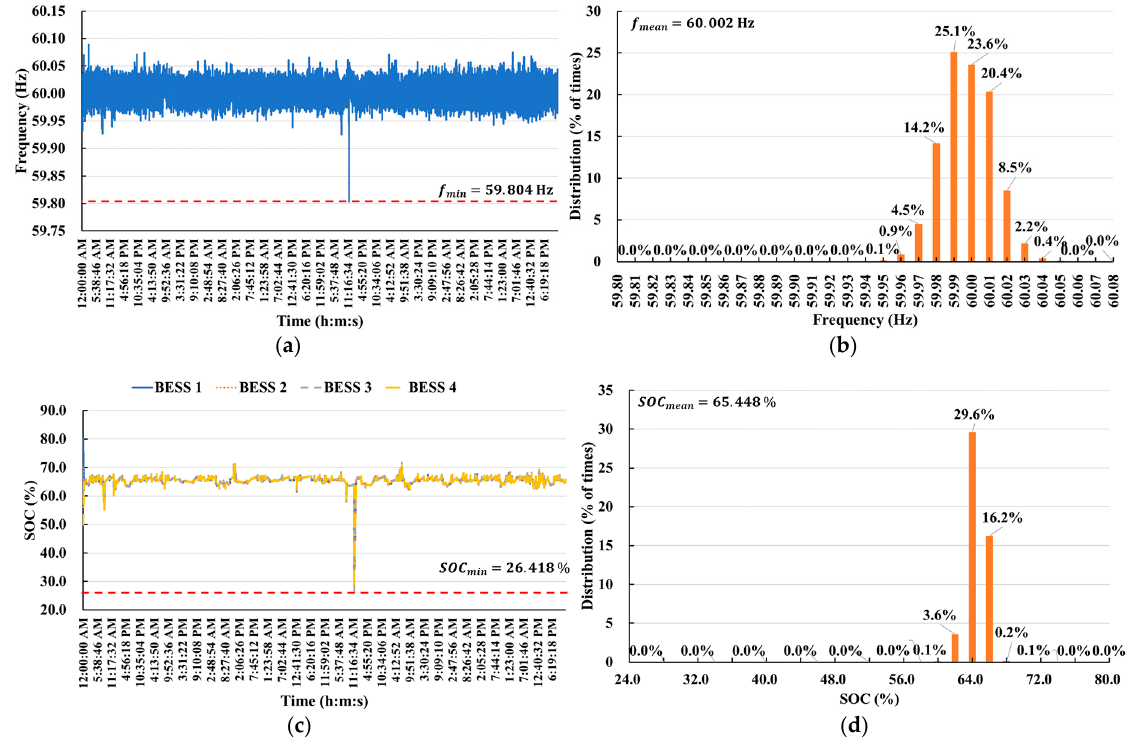
Figure 11. Frequency data for the simulation and SOC result: ( a ) measured frequency data for eight days; ( b ) distribution of frequency data; ( c ) SOC results from four BESS; and ( d ) distribution of SOC.